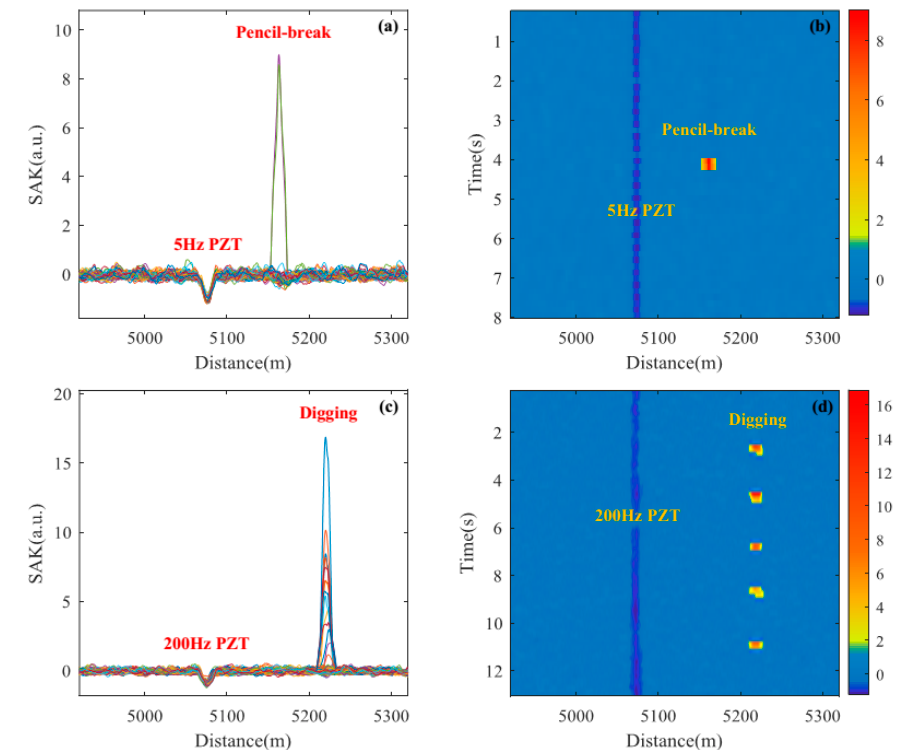
Figure 10. The location results of piezoelectric transducer (PZT) and instantaneous destructive perturbations (pencil-break and digging) through proposed method. ( a ) The SAK curves of 5 Hz PZT vibration plus pencil-break vibration; ( b ) The SAK image of 5 Hz PZT vibration plus pencil-break vibration; ( c ) The SAK curves of 200 Hz PZT vibration plus digging; ( d ) The SAK image of 200 Hz PZT vibration plus 5 digging events.